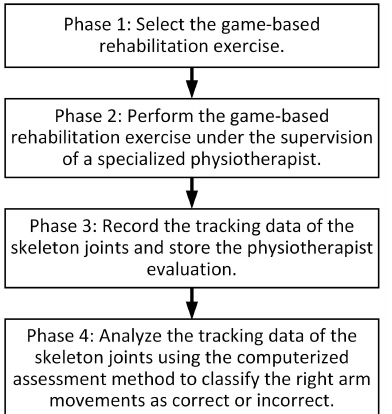
Figure 2. The architecture of the proposed bespoke game-based rehabilitation